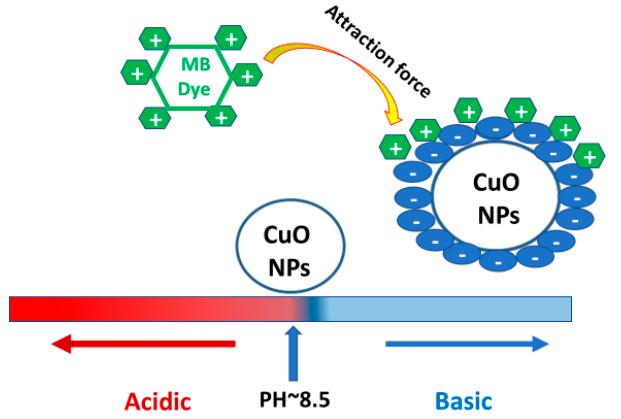
Scheme 3. Role of zero-point charge of CuO NPs on the degradation of cationic dye.